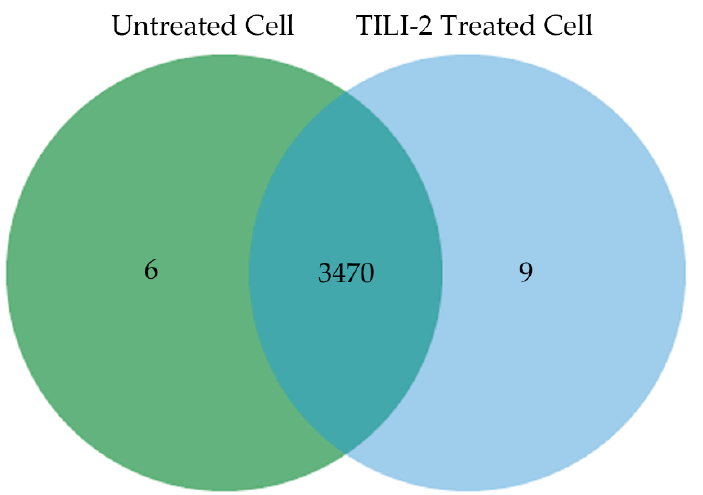
Figure 6. Venn diagram of identified proteins of untreated B16F1 cells overlapped with TILI-2 treated B16F1 cells.